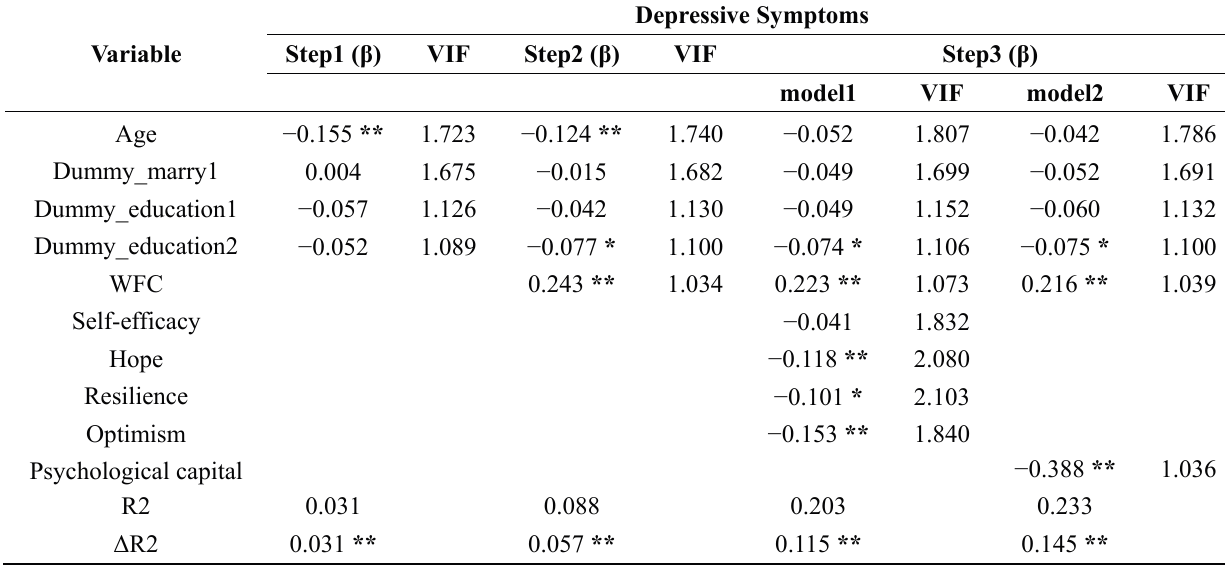
Table 10. Hierarchical linear regression analysis results of WFC.